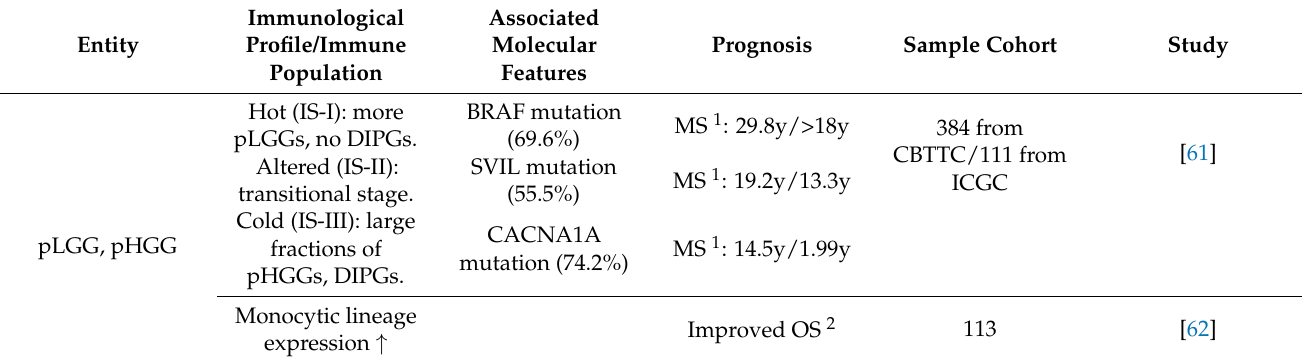
Table 1. Associations between immune microenvironment and molecular features/prognosis in pediatric brain tumors. Immunological Entity